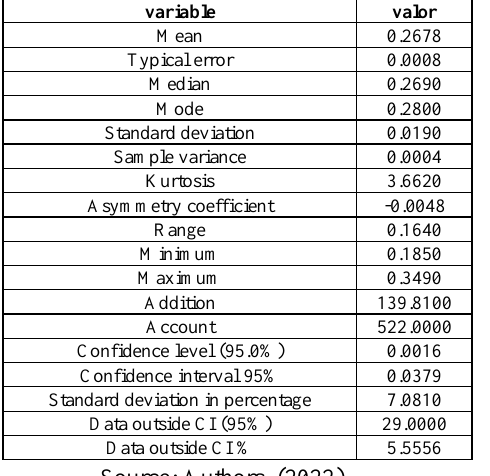
Table 1: Initial statistical analysis (Phase 1).